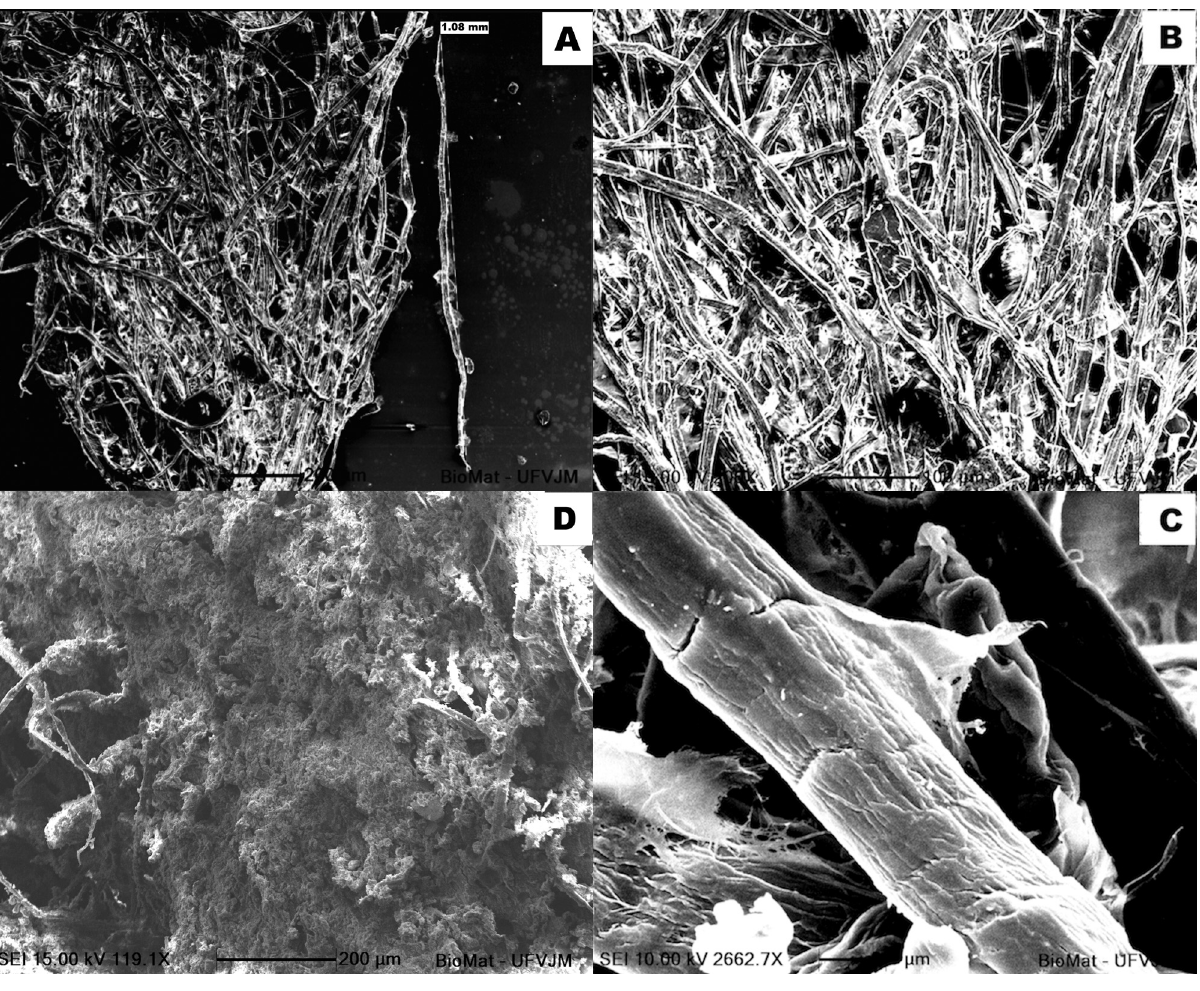
Figure 1. SEM images of the surface morphology of eucalyptus cellulose fibers after physical processing, magni- fied (A) × 20, (B) × 200, and (C) > × 2,500; and (D) fracture area of the GICMF2 composite (× 100); 10 and 15 kV;